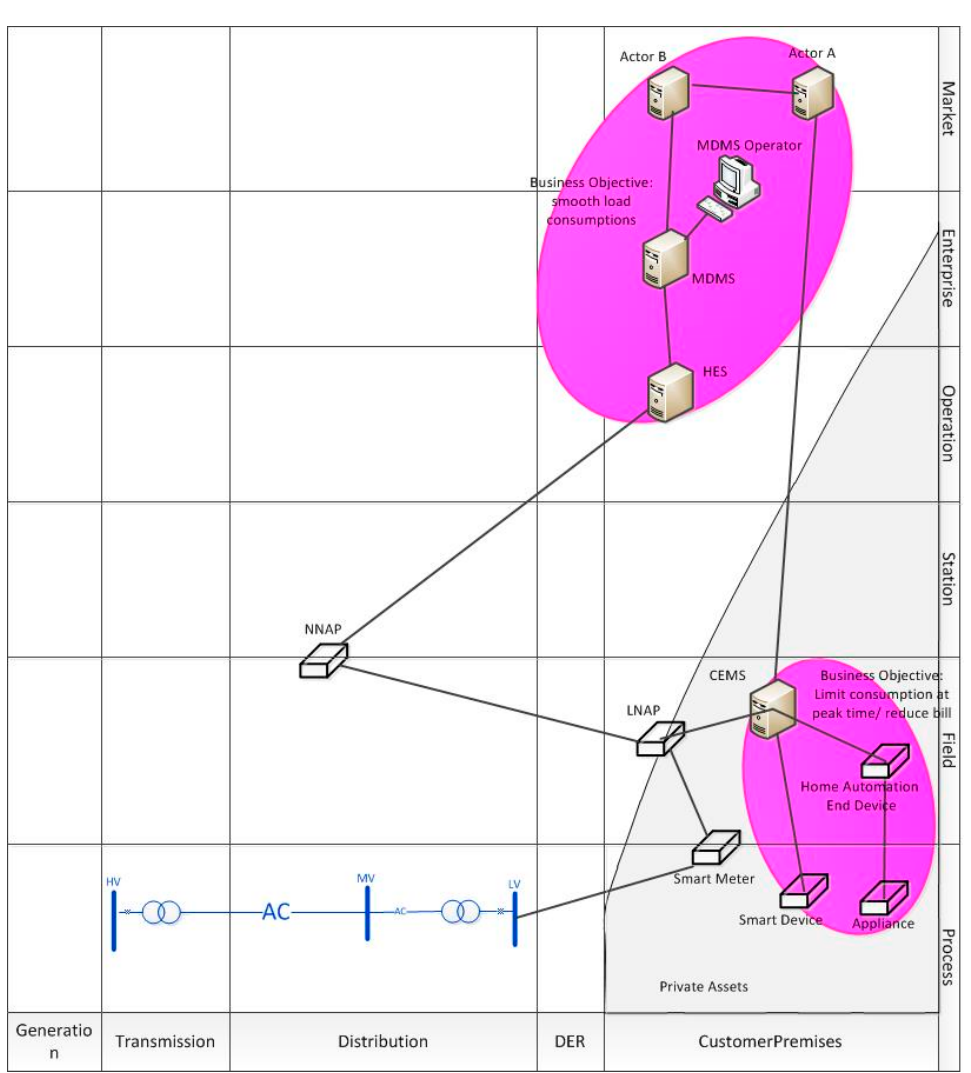
Figure 5. Business Layer.